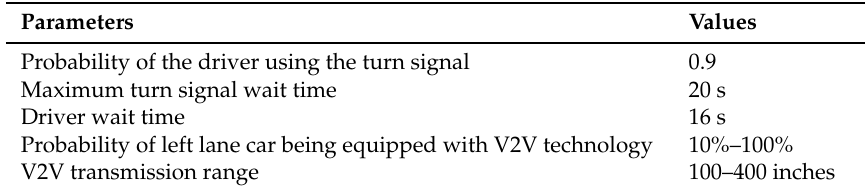
Table 2. Common simulation parameters for the vehicle-to-vehicle (V2V) simulation studies.